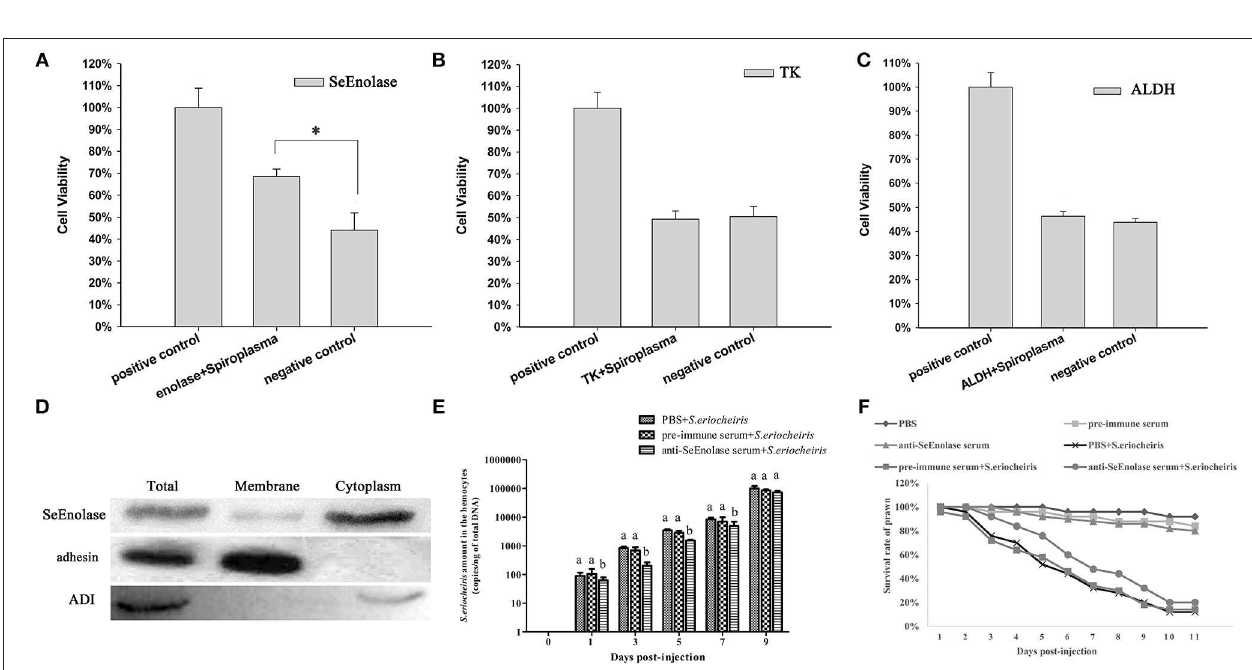
FIGURE 4 | SeEnolase proteins mediate S. eriocheiris invasion into M. rosenbergii hemocytes. (A–C) Show competitive binding experiments with SeEnolase, TK, and ALDH, respectively. M. rosenbergii hemocyte were incubated with different ligand proteins and infected by spiroplasma. Cell viability was determined with CCK-8. Cells used for different treatments are shown on the abscissa, and relative cell viability rate on the ordinate. Vertical bars depict the mean ± S.E ( n = 36). Significant differences were analyzed using one-way ANOVA by post-hoc Duncan multiple range tests. * p < 0.05. (D) Subcellular localization of SeEnolase. Western blotting was used to analyze the location of SeEnolase, three lanes are represented: total protein, membrane proteins, and cytoplasmic proteins of S. eriocheiris , respectively. (E) The quantification of S. eriocheiris copies in hemocytes from the three groups detected by real-time PCR at 1, 3, 5, 7, and 9 days, respectively. Differences between each group were analyzed using one-way ANOVA. Different letters indicate statistical significance ( p < 0.05) and the same letter indicate no statistical difference ( p > 0.05). (F) The survival rate of prawn infected using S. eriocheiris pretreated with antibody. Pretreated bacteria with anti-SeEnolase serum, pre-immune serum, or PBS were injected into prawn for the anti-SeEnolase serum + S. eriocheiris , pre-immune serum + S. eriocheiris, or PBS + S. eriocheiris group. Three another groups were injected with the anti-SeEnolase serum, pre-immune serum, and PBS, respectively. The cumulative mortality of prawns was recorded daily.